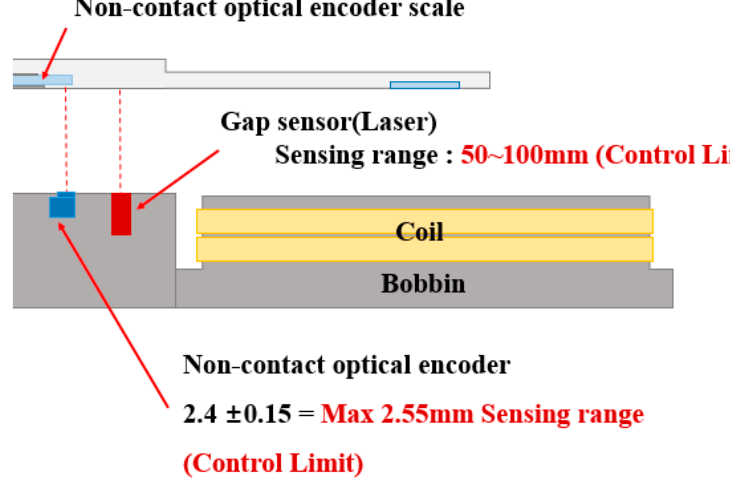
Figure 7. Control limit setting using Z-axis sensing range of non-contact encoder and Gap Sensor.